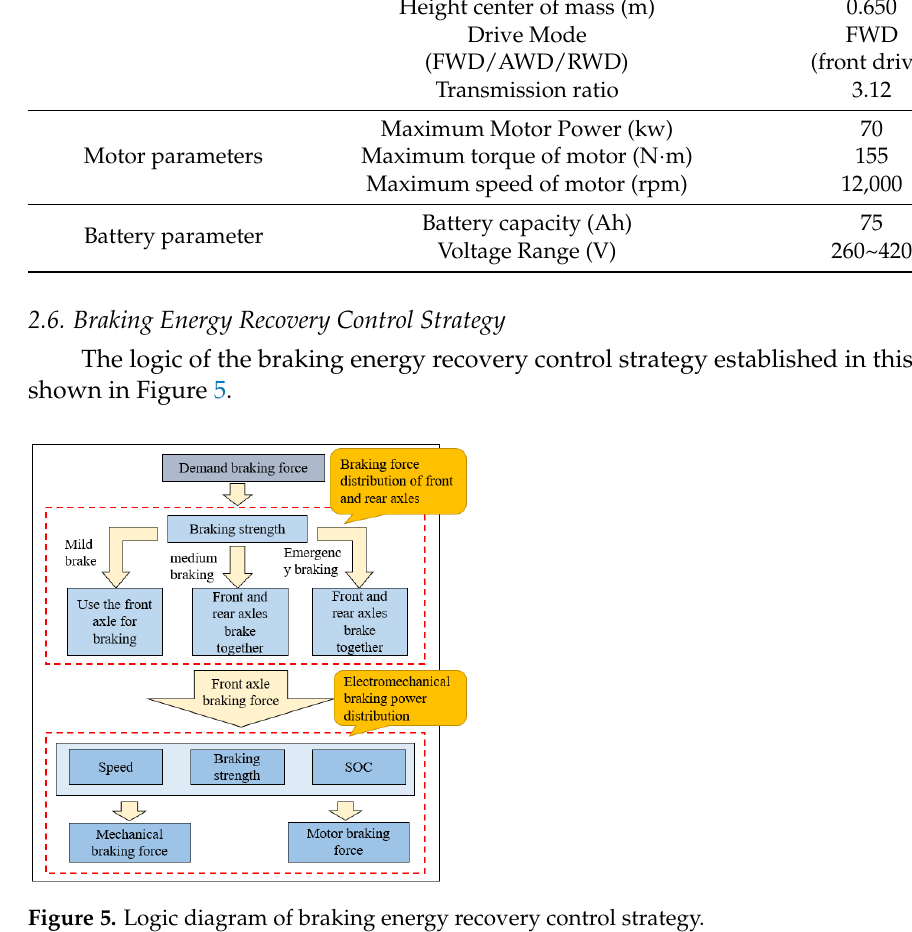
Figure 5. Logic diagram of braking energy recovery control